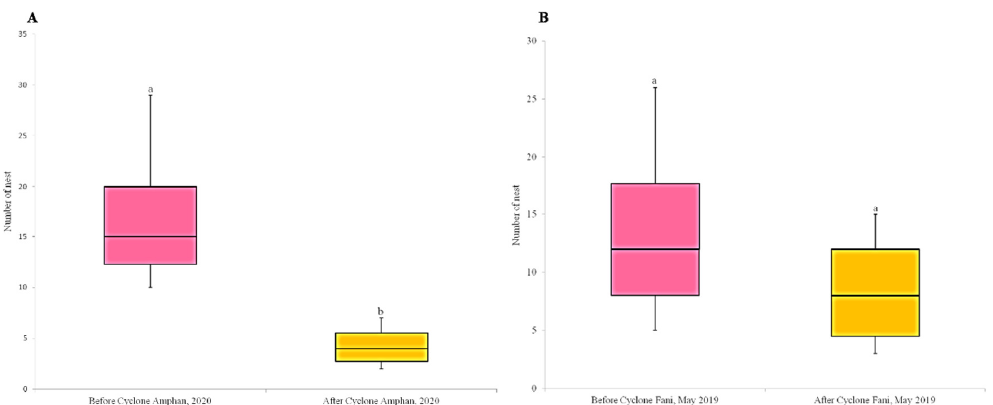
Figure 8. Box plots representing the effect of tropical cyclones A. Amphan and B. Fani on total nest count Each box plot shows minimum, lower quartile, median, upper quartile, and maximum values. Mean values were compared using one-way ANOVA with pair-wise comparisons made with Tukey's HSD (honestly significant difference) tests. Nests were recorded in four trees: Phoenix sylvestris , n=273; Azadirachta indica , n=134; Terminalia arjuna , n=85 and Tamarindus indica , n=59. Groups not sharing lowercase letters are significantly different (Tukey’s HSD test, p <